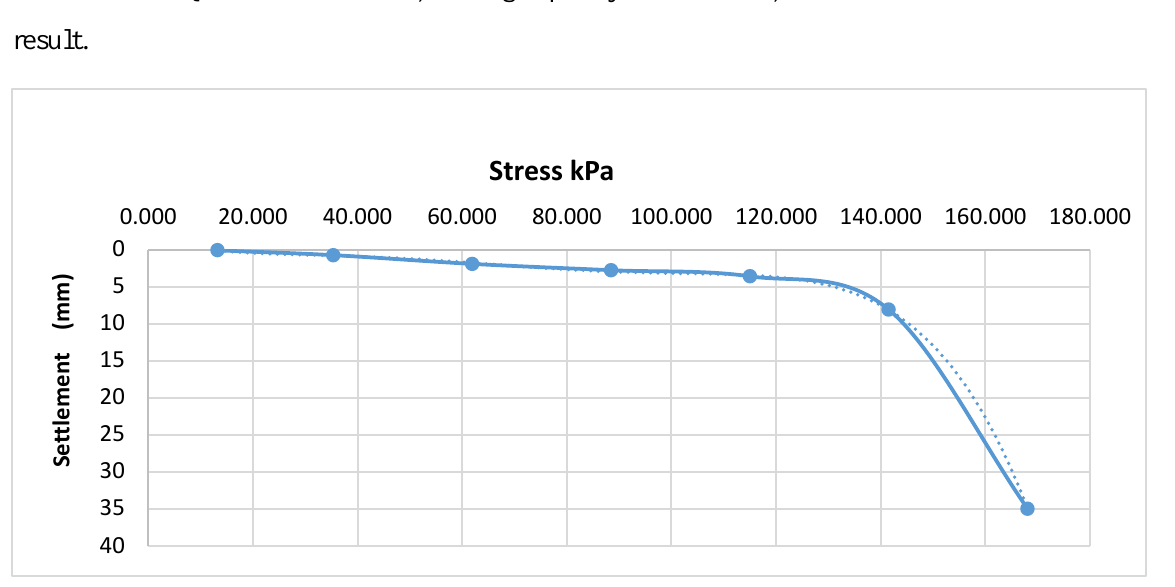
Fig. 12. Experimental model Relationship between Normal Stress versus Vertical Settlement for Natural